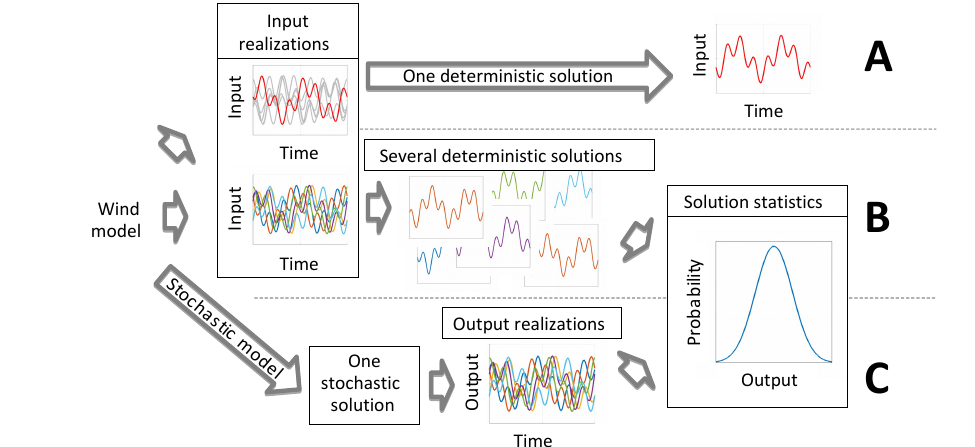
Figure 1. Comparison of the solution processes in a pure deterministic (A), a deterministic–statistic (B), and a stochastic framework (C).